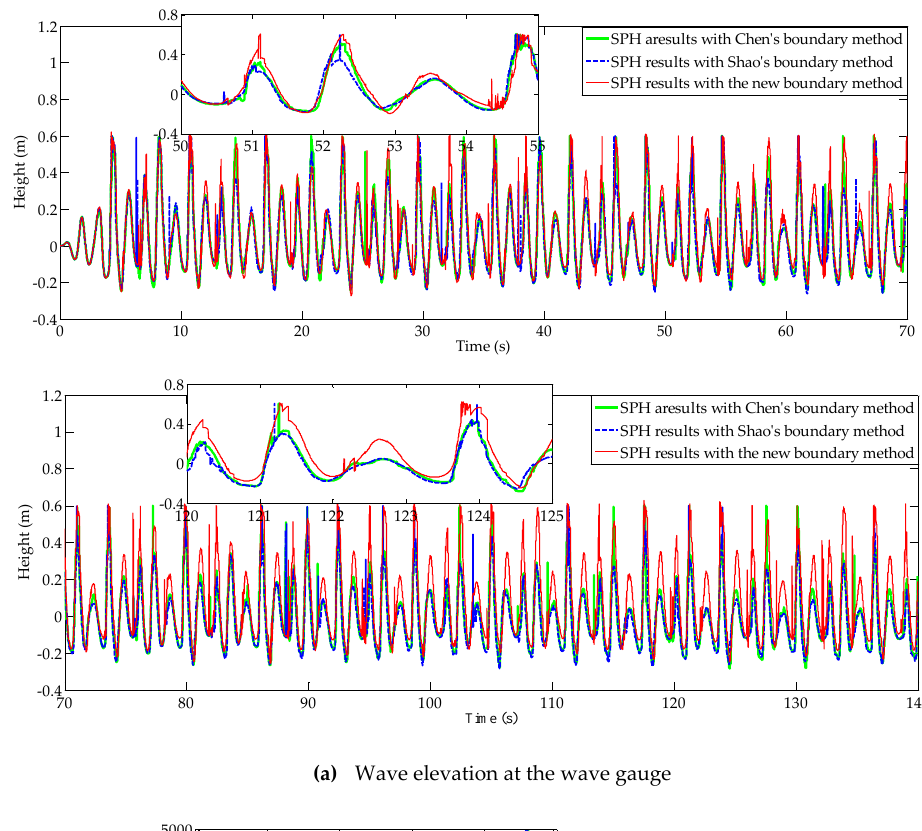
Table 3. Numbers of penetration particles in the SPH simulations.